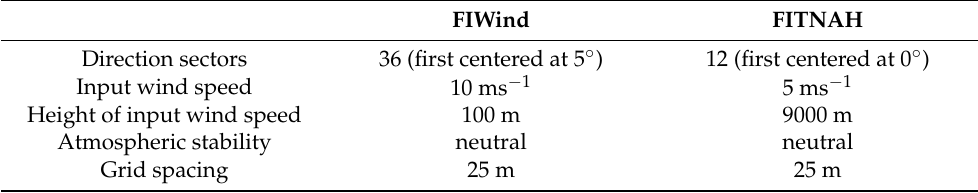
Table 3. Specifications of FIWind and FITNAH model setup for the study presented in this